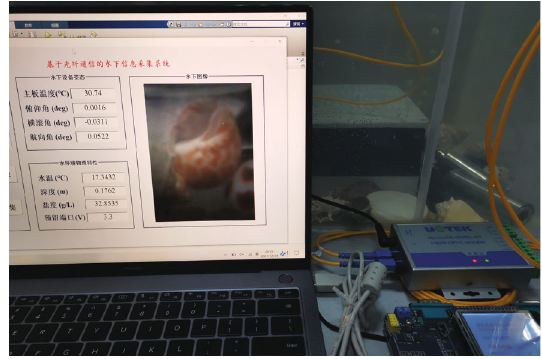
Figure 8: Underwater experiment of the prototype. Table 1: Relative errors of temperature, salinity, and